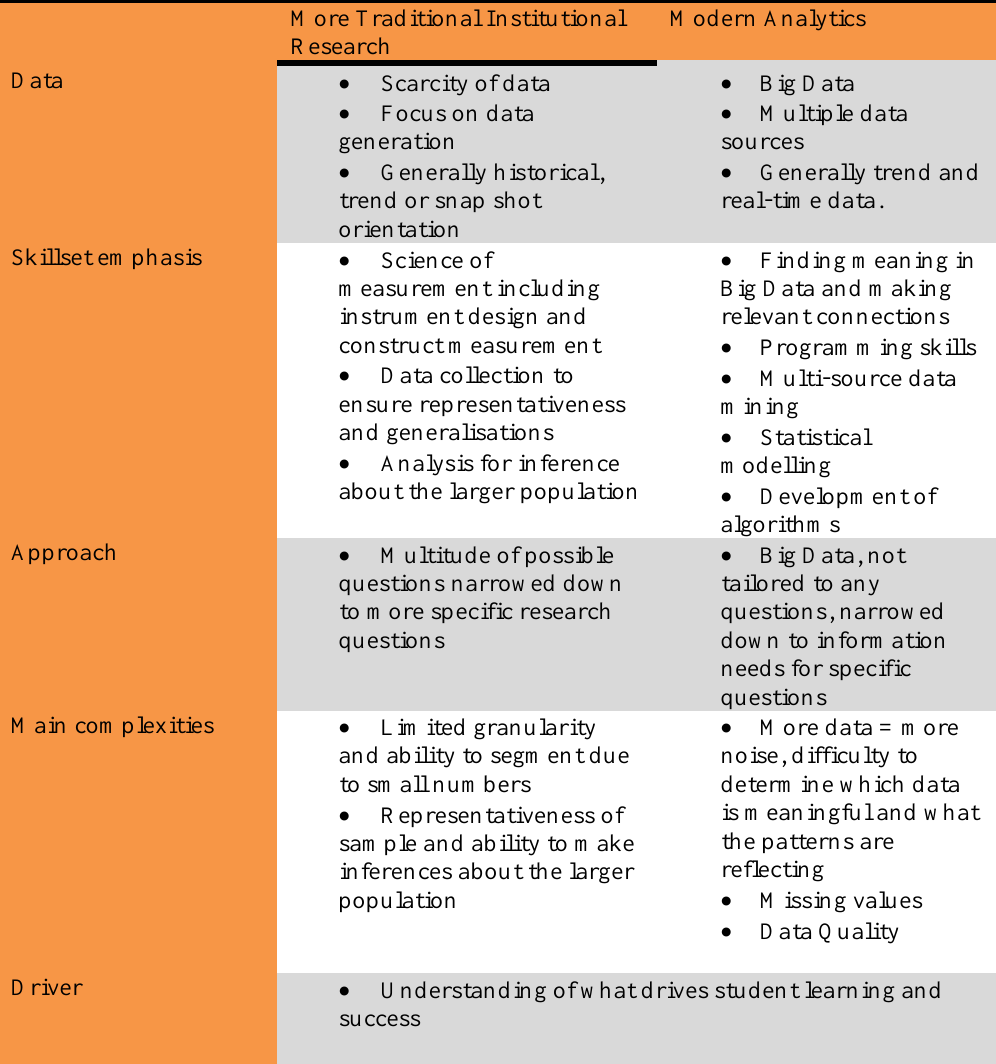
Table 1 Shifts from Traditional Institutional Research Skills to the Demands of Modern Analytics More Traditional